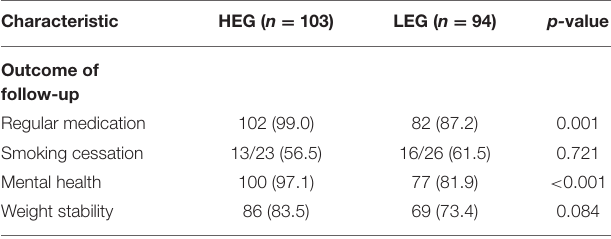
TABLE 2 | Outcome of follow-up.